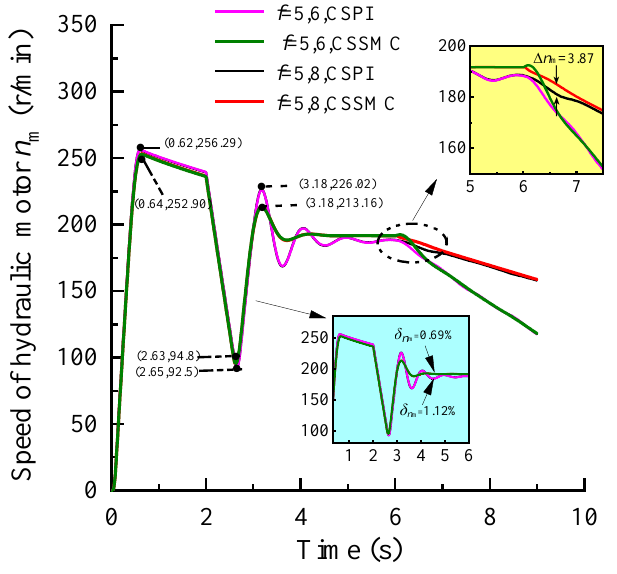
Figure 7. Variation curve of the hydraulic motor speed based on the CSPI and CSSMC.